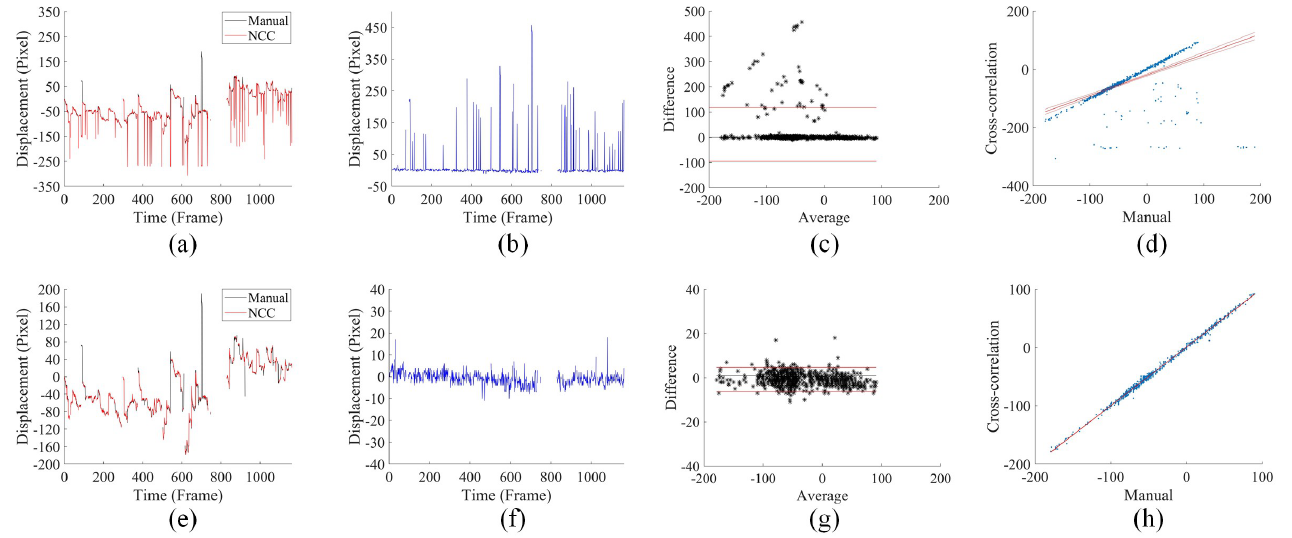
Figure 11. Vertical displacement comparison chart; ( a ) shows the comparison of vertical displacement obtained by cross-correlation-based methods and manual registration; ( b ) is the difference between the two methods; and ( c ) is the Bland–Altman plot. The black line is the mean difference of the two methods. Red lines indicate the 95% confidence interval (mean ± 1.96 × standard deviation). The Pearson correlation coefficient curve is shown in ( d ), and ( e – h ) show the results after removal of the wrong displacement. The frame number in the x-axis corresponds to the frame number in the original video.